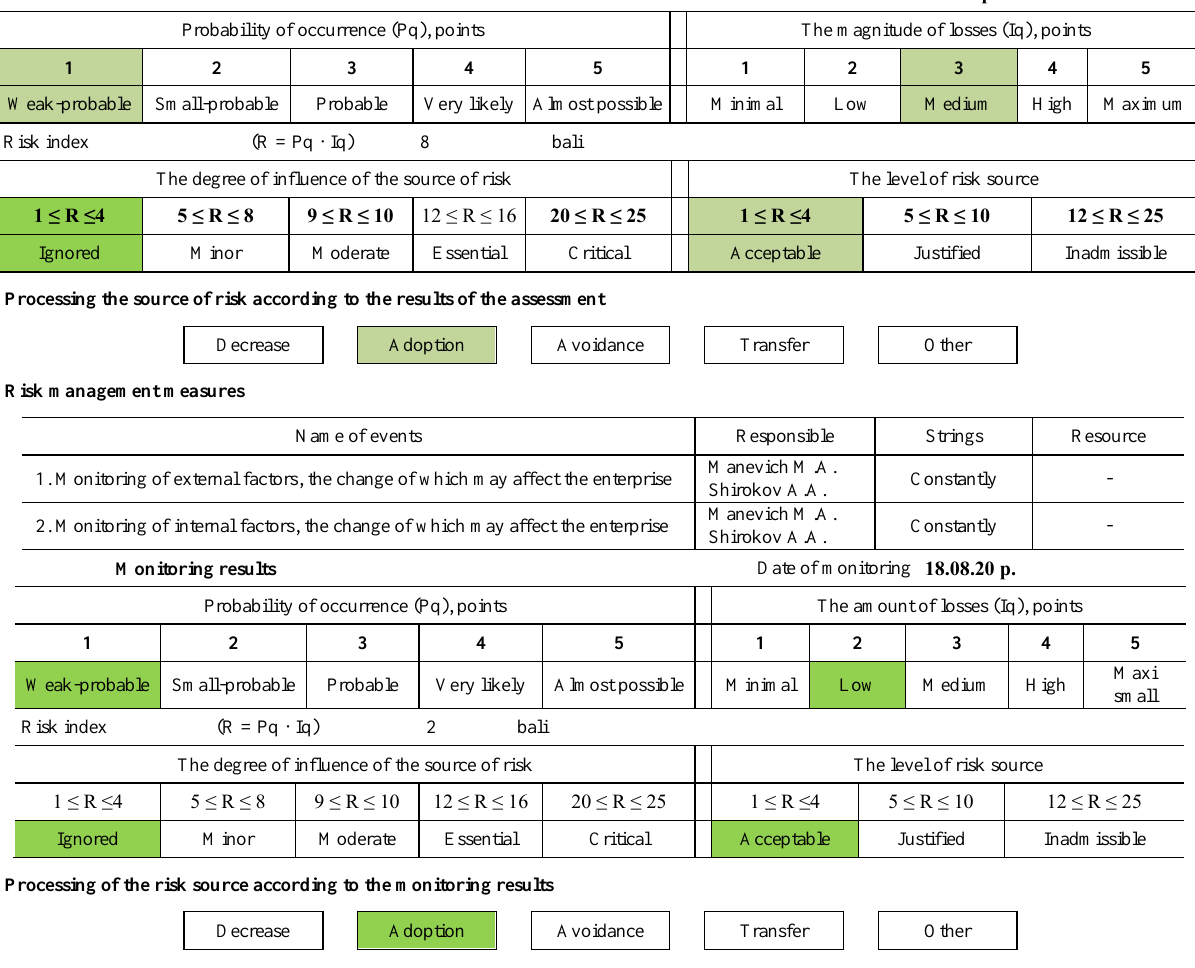
Figure 6. Example of a risk